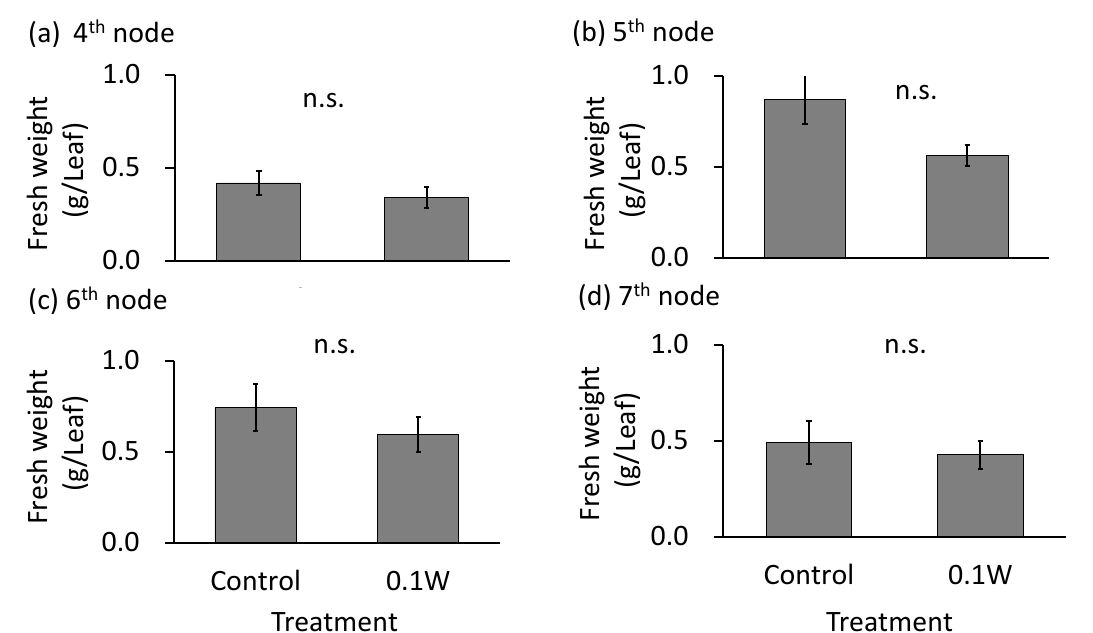
Figure 1. Effect of exposure to 6 h of nocturnal UV-B lighting on leaf fresh weight of red perilla plants (Experiment 1). Perilla plants were irradiated for 6 h from 23:00 to 05:00 h in all UV-B light treatments. UV-B radiation intensity at the top of the plant canopy was set to 0.1 W m − 2 . The integrated UV-B energy at 0.1 W m − 2 was 2.2 kJ m − 2 day − 1 . Leaves at the 4th node counted from the bottom of the main stem were harvested 1 week after treatment initiation; thereafter, leaves at the 5th, 6th, and 7th nodes were sampled from the same plants at 2, 3, and 4 weeks after treatment initiation. Vertical bars indicate SE ( n = 6). n.s. indicates no significant difference as per the t -test.